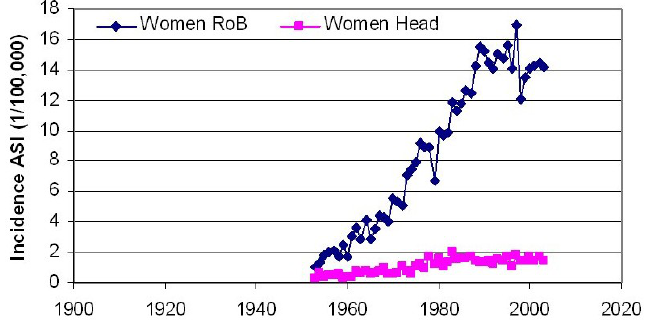
Figure 3. The incidence of melanoma in women in Norway roughly doubled on the head region after 1955 while it increased by almost 20 times on the rest of the body (RoB)